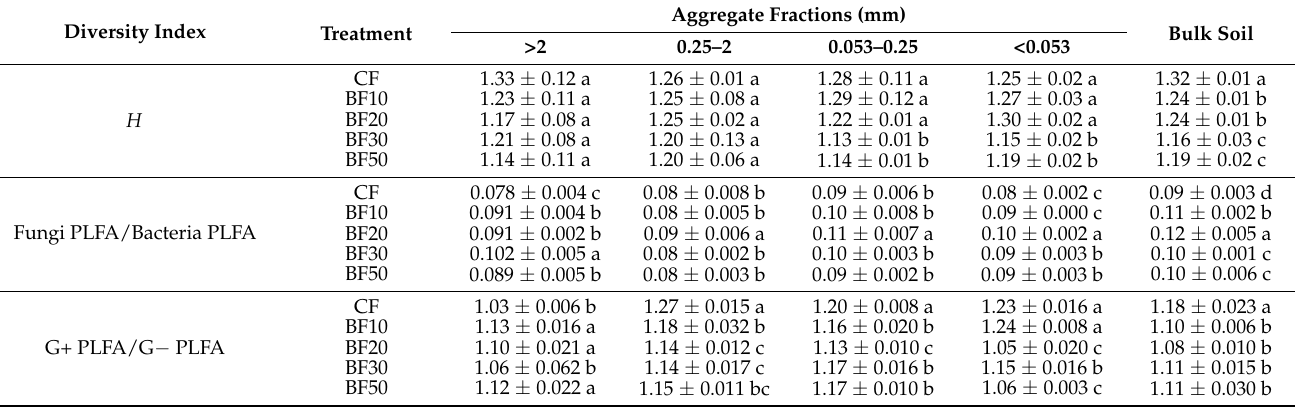
Table 3. The diversity of soil microbial community in aggregate fractions and bulk soil in different treatments.